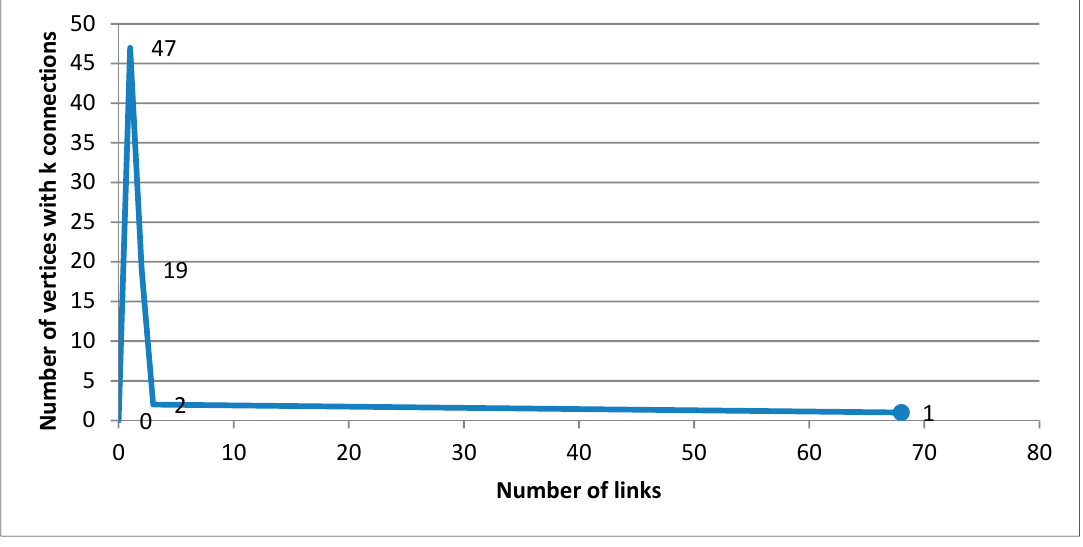
Figure 5. Degree distribution of NZBM. Source: Author